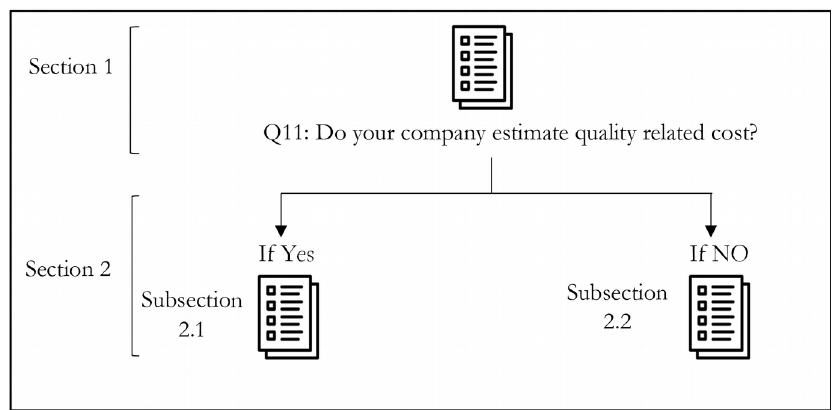
Figure 1. The questionnaire